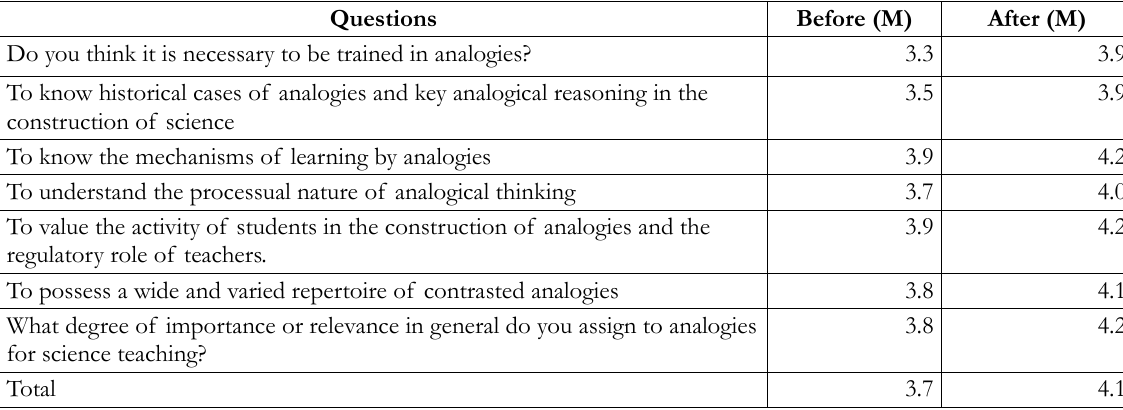
Table 9. Usefulness of analogies for teaching